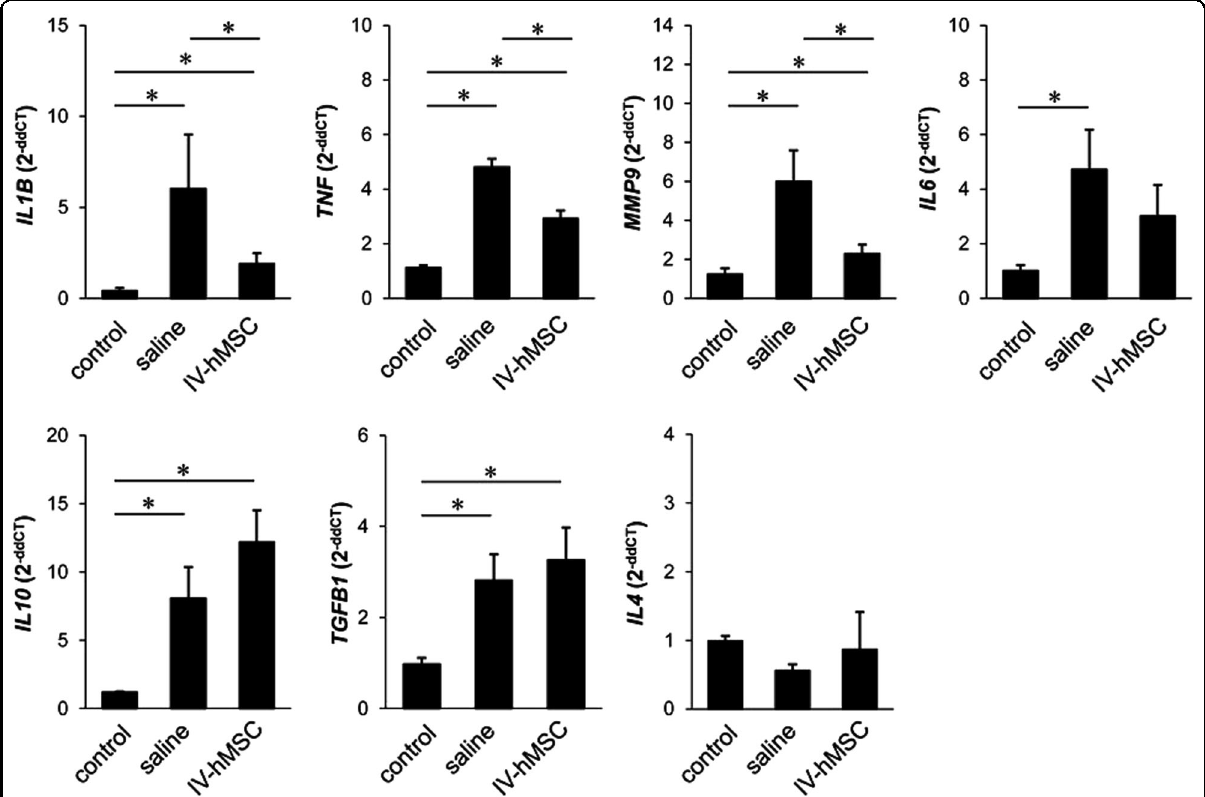
Fig. 3 Gene expression of in fl ammatory cytokines in MCAo rats treated with IV-hUMSCs. Real-time PCR of seven in fl ammatory cytokines among controls ( n = 5), MCAo rats treated with saline ( n = 5), and MCAo rats treated with IV-hUMSCs ( n = 6). The test was duplicated for each gene, and the mean value was used for statistical analysis. The fold difference was represented as a 2 − ddCT value that was calculated by the comparative threshold (C T ) cycle method. All data are presented as the mean ± SEM. The expression level of each gene was normalized to GAPDH. * p <